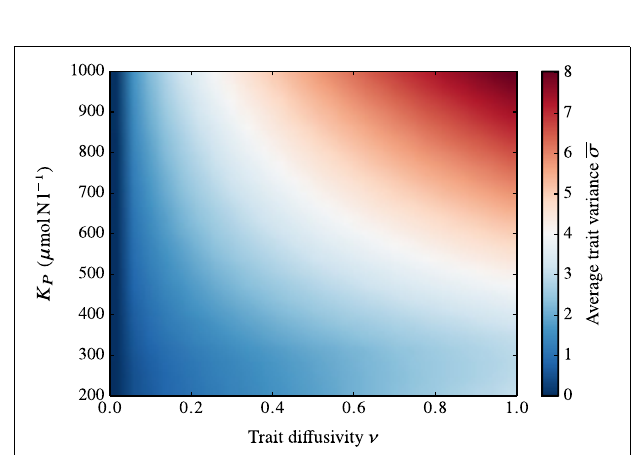
FIGURE 5 | Behavior of the trait-diffusion model for different values of ν . Being proportional to reproduction, the trait diffusivity parameter ν affects the adaptive capacity of the phytoplankton community as the probability of generating offspring with new trait values increases. ν = 0 represents the standard case in which functional diversity is not sustained. The larger ν , the more pronounced are the oscillations in the mean edibility and the larger is the trait variance. The corresponding NPZ dynamics is shown in Supplementary Figure 5.